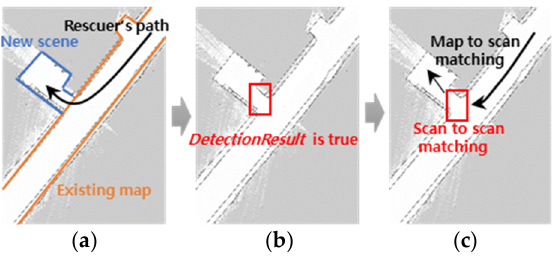
Figure 1. Advanced TSD-SLAM process: ( a ) g athering a significantly different new scene; ( b ) d etecting the matching failure point; ( c ) scan-to-scan matching is performed instead of map-to-scan matching at the point.